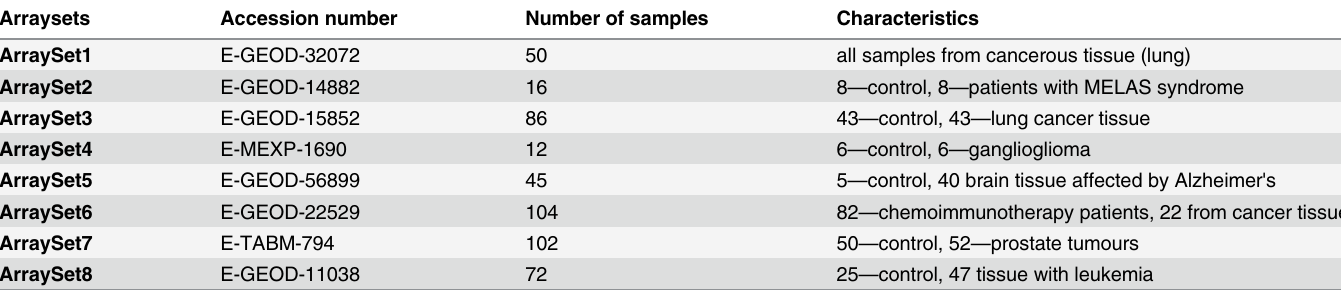
Table 2. Arraysets